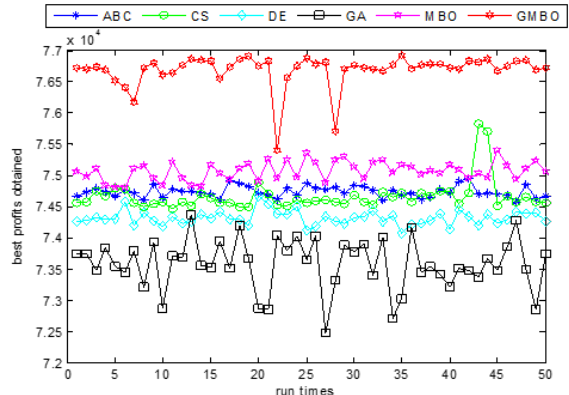
Figure 7. Comparison of the best values on KP4 in 50 runs.